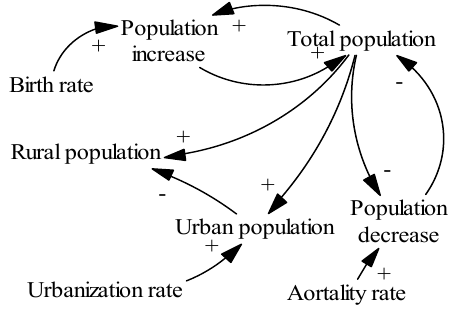
Figure 3. Workflow for the population subsystem.